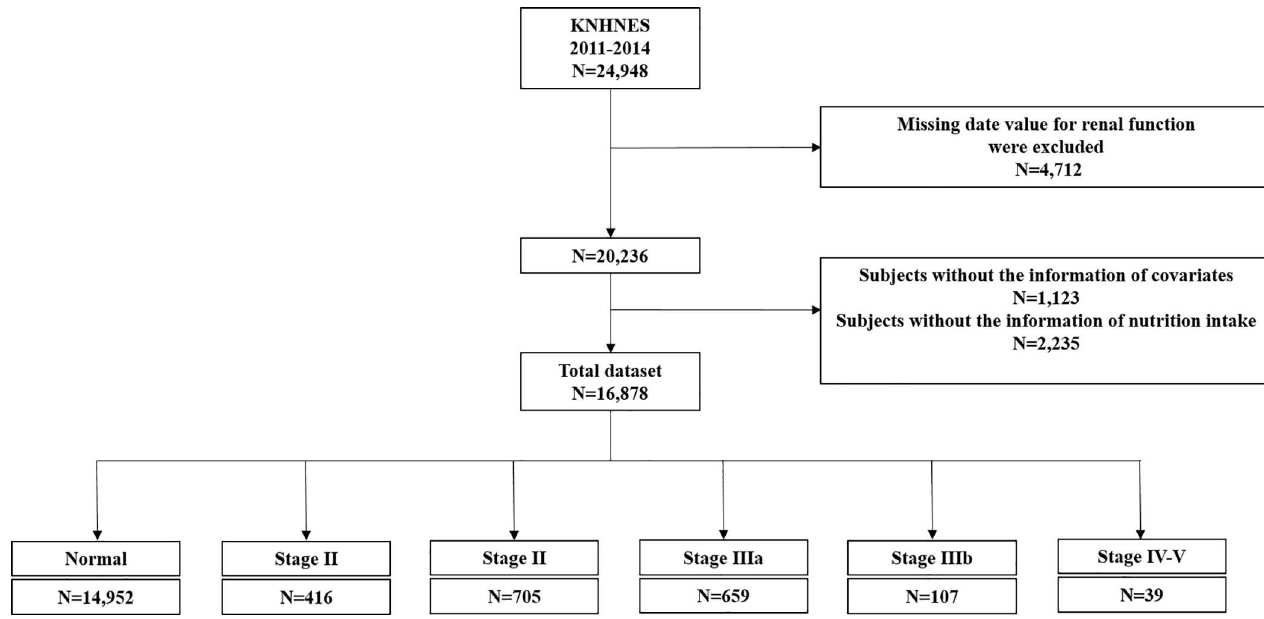
Fig 1. Study design and patient distribution. Abbreviations: KNHNES, Korean National Health and Nutritional Examination Survey.